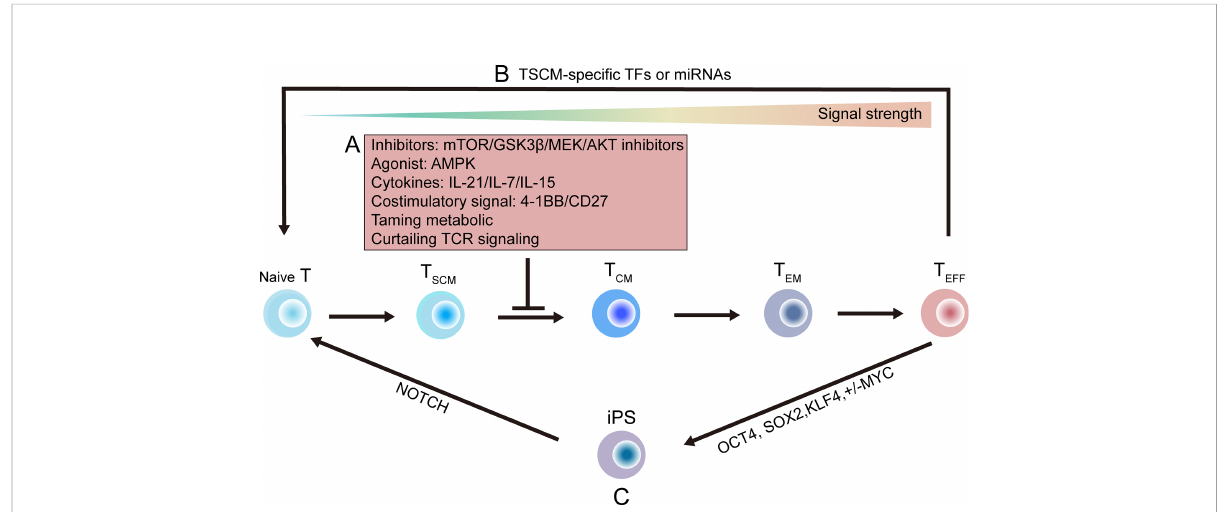
FIGURE 5 Strategies that might be utilized to generate stem-like T cells. (A) Progress of T cells differentiation toward effector T (T EFF ) cell pool depends on the strength of stimulatory signals. Differentiating progress of primed T N cells can be delayed or suppressed by targeted inhibitors (such as mTOR, GSK3 b , MEK, AKT inhibitor); or by using cytokines, such as interleukin ‐ 21 (IL-21), interleukin-7 (IL-7), interleukin-15 (IL-15), or by using proper costimulatory signal; or by taming metabolic modulators; or by curtailing TCR signaling (16, 21, 109, 201 – 204). (B) Direct reprogramming methods using naïve- or stem-associated factors or miRNAs (205, 206). (C) A two-step induction method is shown. By enforcing expression of OCT4, SOX2, KLF4 and MYC, terminal T EFF cells can be programmed into iPS cells, which are then re-differentiated into TN cells by inducing NOTCH signals (207 – 214). GSK3 b , glycogen synthase 3 b ; T N , naïve T; T EFF , T CM , effector T; iPS, induced pluripotent stem; OCT4, octamer- binding transcription factor 4; SOX2, sex determining region Y BOX 2; KLF4, Kruppel-like factor